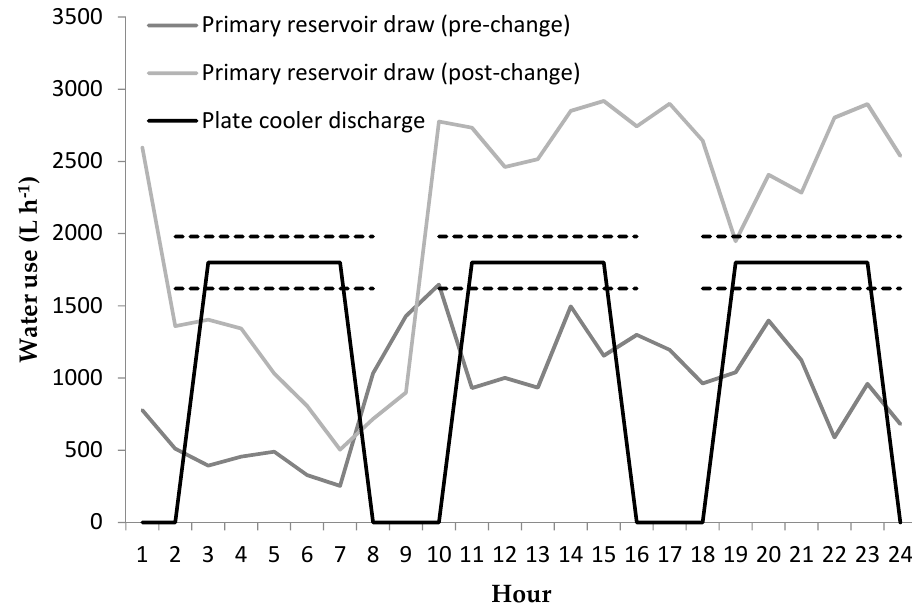
Figure 6. Typical day showing hourly water draw from primary reservoir (L) ( pre - and post - change in plumbing design) and milk pre-cooling water use based on the average flow rate (L) ± 1 SD (dashed lines) at times of operation (0300 h, 1100 h, and 1900 h milking times). Water is wasted as overflow when the plate cooler discharge exceeds the primary reservoir draw.